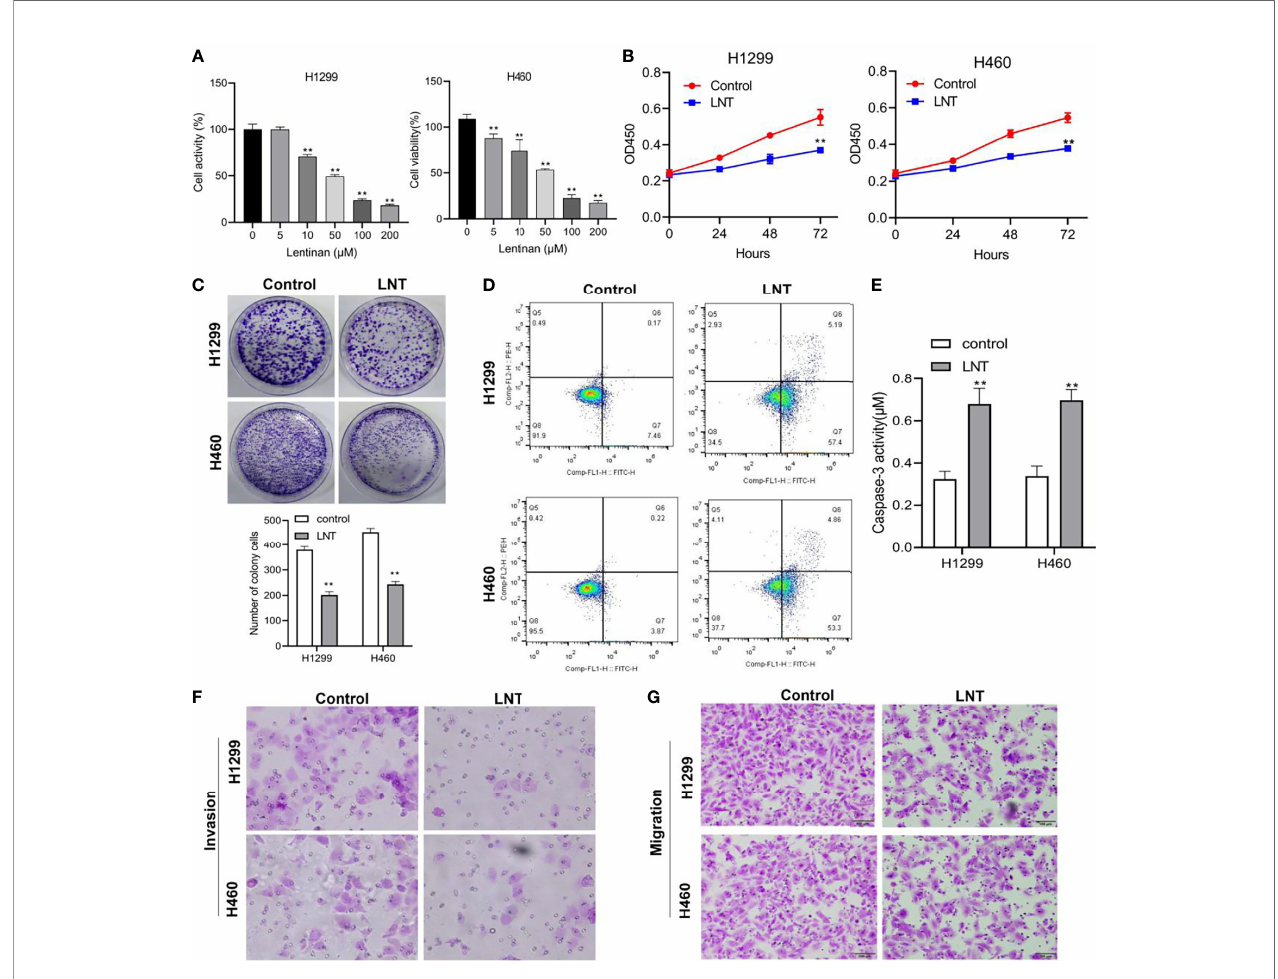
FIGURE 1 | LNT effects on human lung adenocarcinoma cell malignant development. (A) CCK-8 detects H1299 and H46 cell viability under the intervention of different concentrations of LNT; After treatment of H1299 and H460 cells with 100 m M of LNT, (B) CCK-8 assay was used to detect cell proliferation at 24, 48, 72 h; (C) The proliferation capacity of cells was determined by colony assay; (D) Cell apoptosis was measured via fl ow cytometry; (E) Caspase3 activity was examined; (F, G) . Transwell assay were performed to detect cell invasion (F) and migration (G) . All experiments were repeated three times. **P < 0.01 vs . control